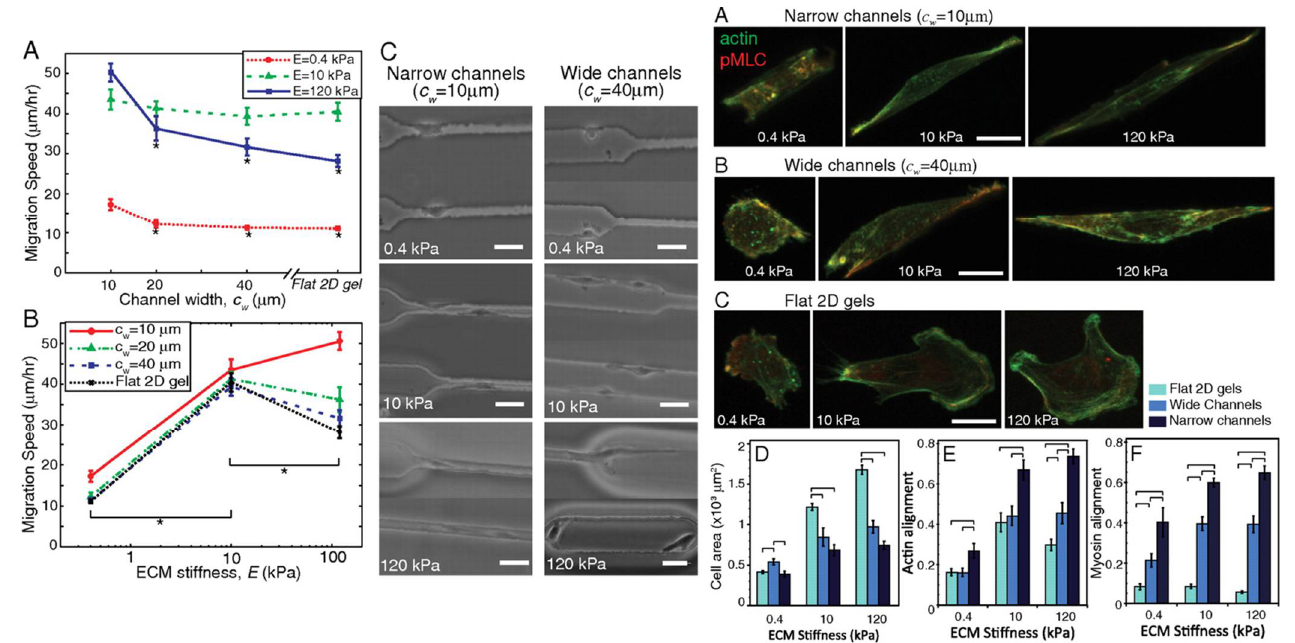
Figure 6. Cell migration, cell area, actin alignment, and myosin alignment when exposed to different channel widths and hydrogel stiffnesses. ( A – C , left panel ) Migration speed was quantified for cells cultured in narrow or wide channels with varying stiffness. With increased stiffness but decreased channel width, cell migration speed was higher. * p < 0.05. ( A – D , right panel ) Cell area, actin alignment, and myosin alignment were quantified from cells imaged after culture in wide or narrow channels with varying stiffness. Cells cultured in stiffer conditions with narrow channels exhibited increased actin and myosin alignment but lower cell spreading than those in narrow channels. Figure reprinted/adapted with permission from Ref. [102]. Copyright 2012, National Academy of Sciences.